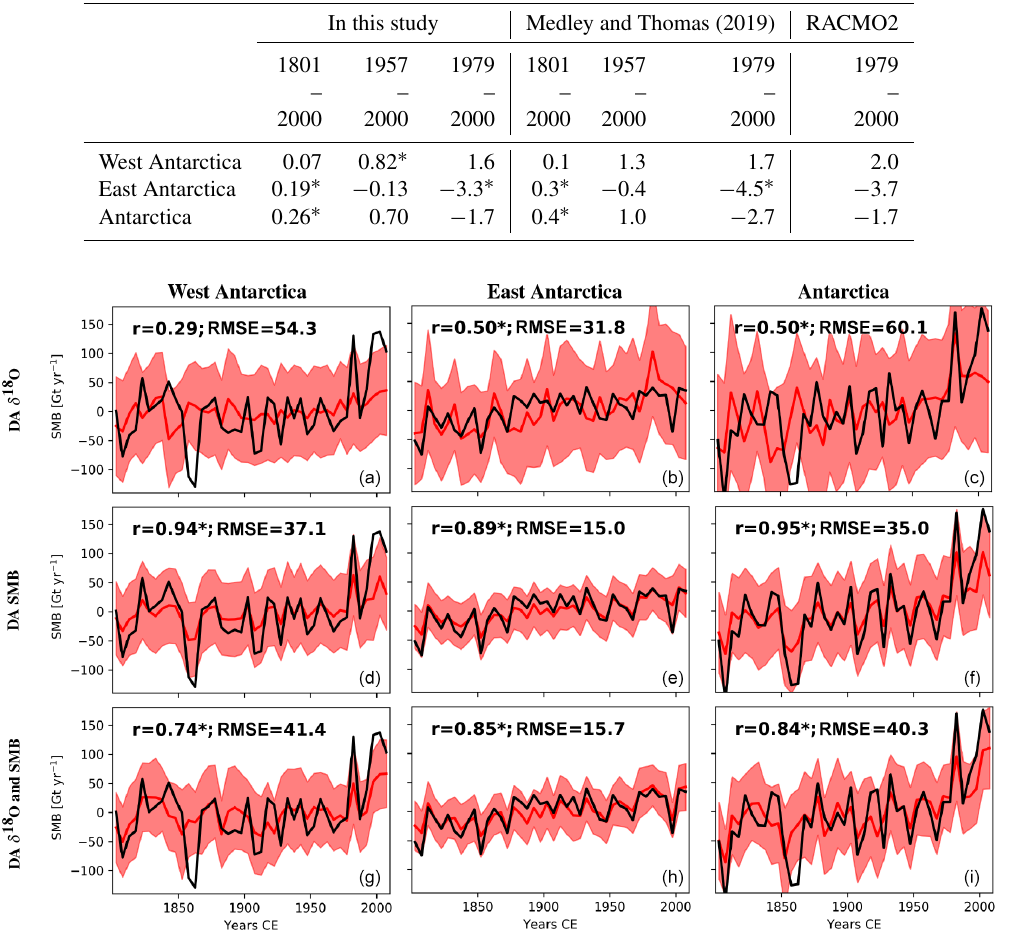
Figure 8. Reconstructed SMB (5-year mean) for West Antarctica, East Antarctica, and Antarctica as a whole from the data assimilation experiment using the iHadCM3 outputs and δ 18 O (Stenni et al., 2017a) and SMB reconstruction (in black; Thomas et al., 2017) as constraints in the data assimilation process. The period is 1800–2010. DA δ 18 O (a–c) is the data assimilation experiment using only the δ 18 O data to constrain the model while DA SMB (d–f) uses the SMB reconstruction and DA δ 18 O and SMB (g–i) uses both. For each experiment and each region, the correlation ( r ) between the reconstruction based on ice cores (in black) and that based on data assimilation is computed (in red). The shaded areas represent ± 1 standard deviation of the model particles. Asterisks represent the statistically significant correlations ( p value <